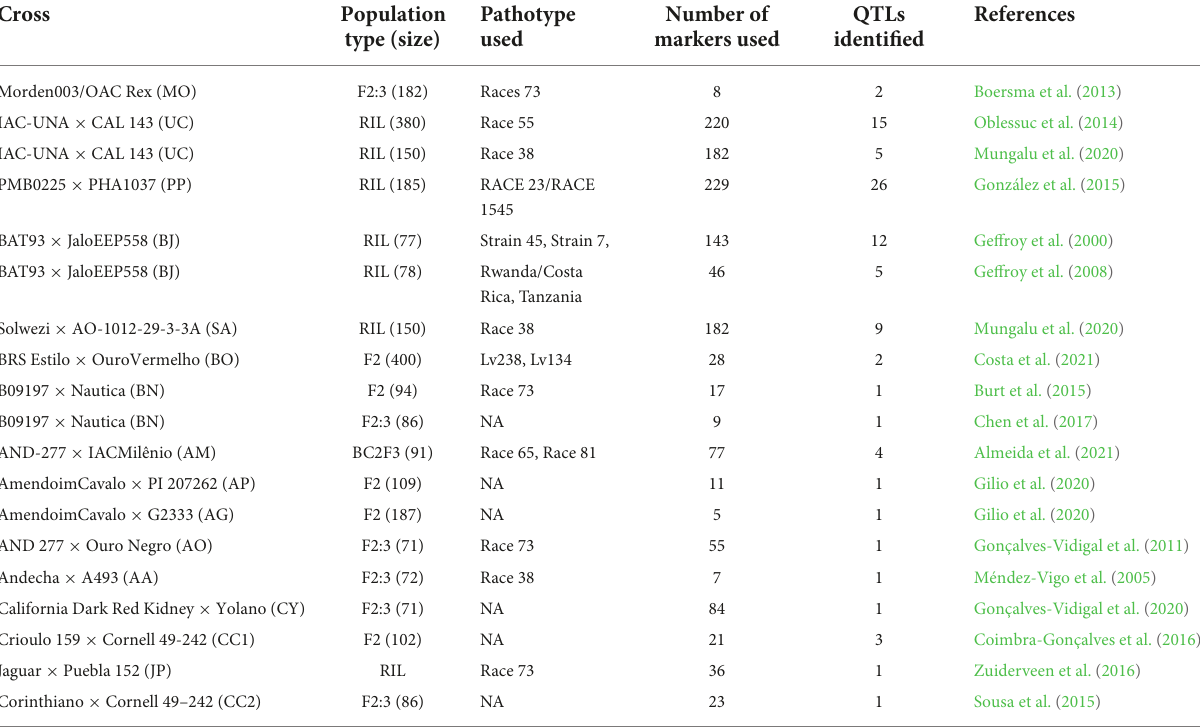
TABLE 1 Details of mapping studies used for anthracnose disease in common bean. Cross Population